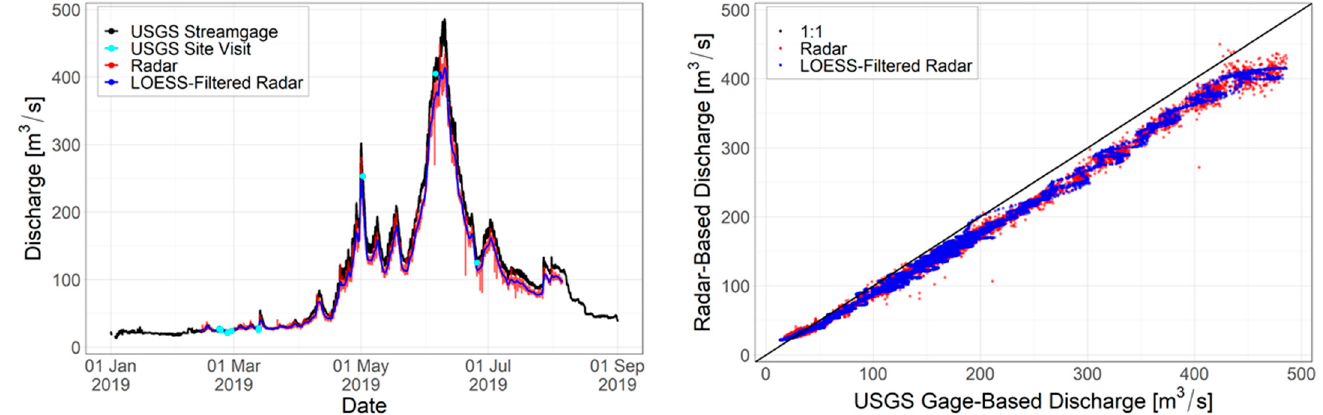
Figure A1. Comparisons of unfiltered (raw) radar-based discharge estimates (red), LOESS-filtered radar-based discharge estimates (royal blue), continuous USGS-streamgage-based discharge esti- mates (black), and USGS site visit stage discharge measurements (cyan), for the fully radar-based, trained- ϕ dataset, including a time series ( left ) and a scatterplot ( right ).